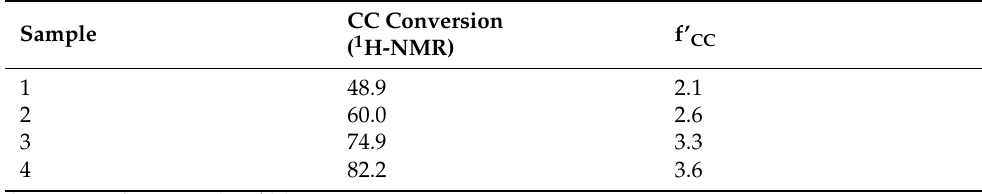
Table 1. Hybrid CSBO conversion and functionality values.